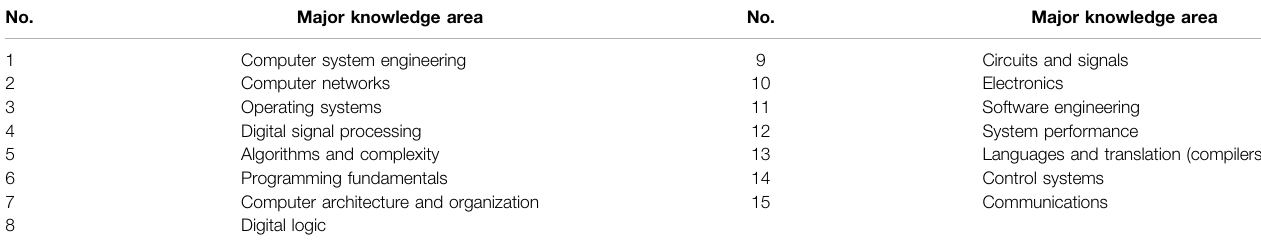
TABLE 1 | Body of knowledge for the embedded system design course (Ilakkiya et al., 2016). No.